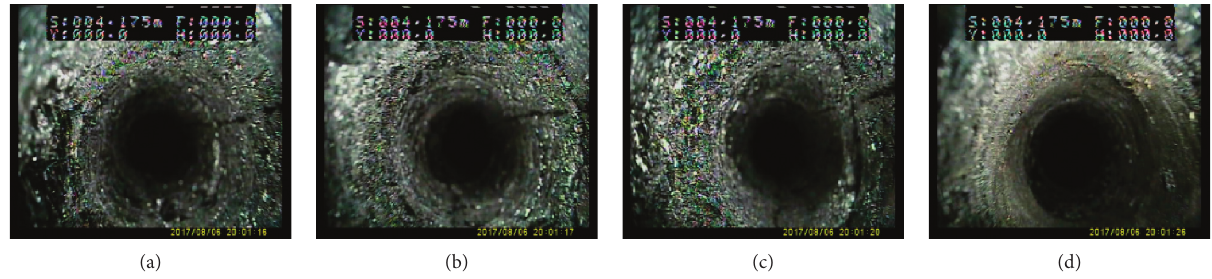
Figure 17: The distribution of the surrounding rock (2.3–2.8m) outside the anchor zone. (a) 2.3m. (b) 2.5m. (c) 2.7m. (d) 2.8